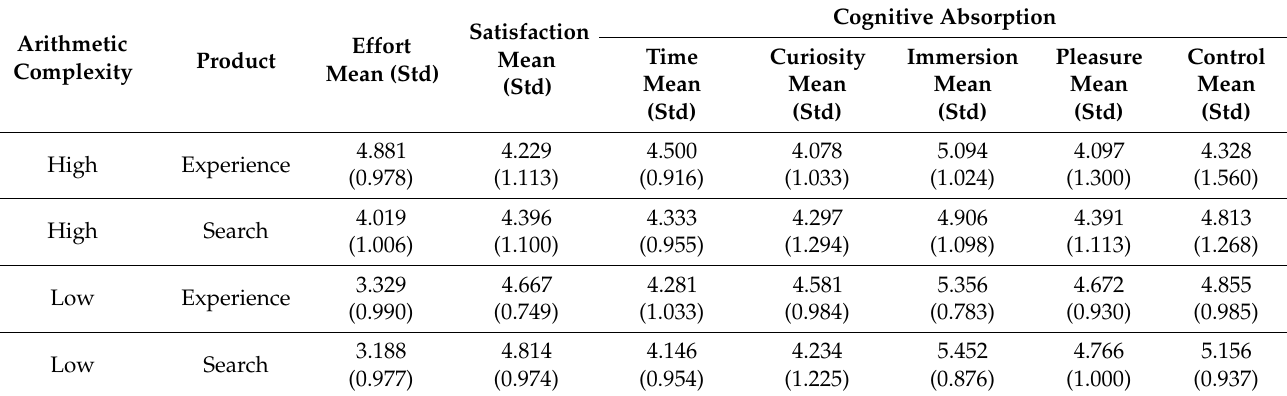
Arithmetic Complexity